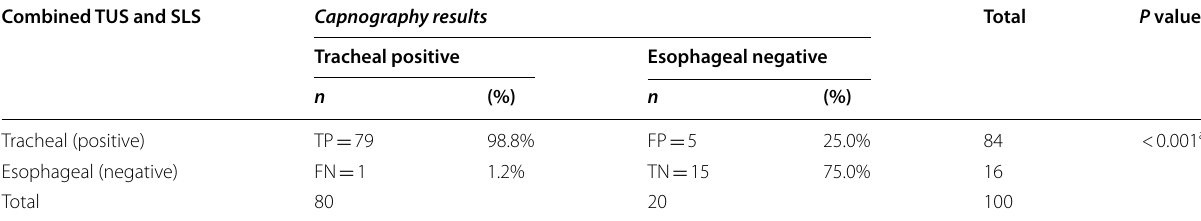
TUS Tracheal ultrasonography, SLS Sliding lung sign; data are presented as number and percentage (%) ( n No. of patients, TP True positives, FP False positives, FN False negatives, TN True